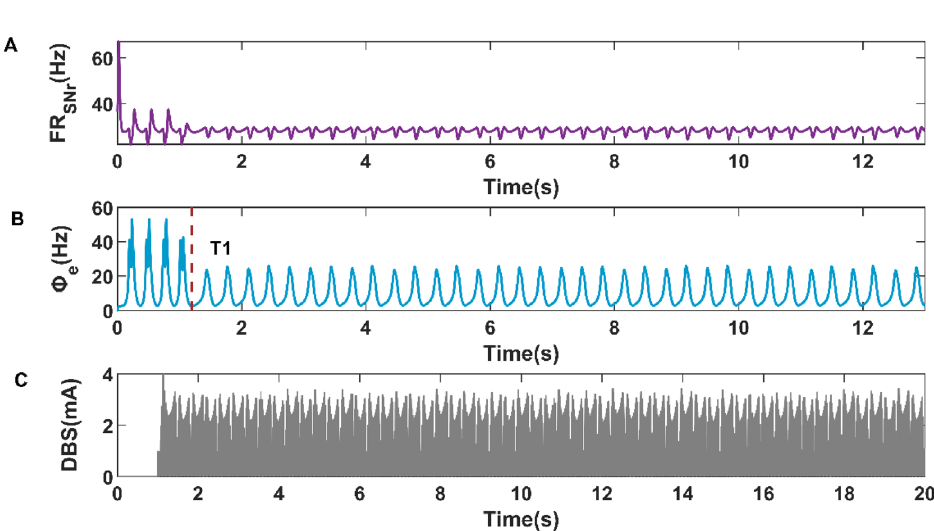
Figure 13. Variations of firing rate of SNr ( A ), firing activity of cerebral cortex ( B ), and the current of closed- loop DBS ( C ) during the closed-loop DBS control when the expected firing rate is 28.4144